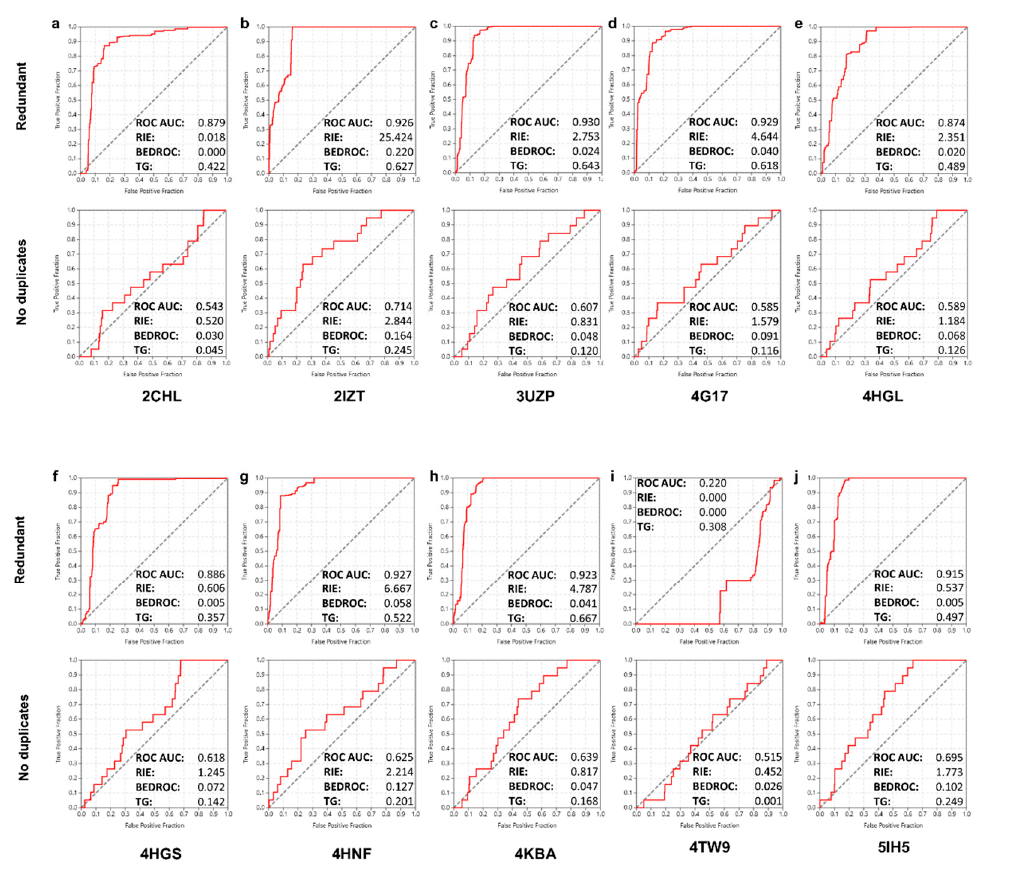
Figure 2. The ROC curves and key enrichment metrics obtained for the subsequent ligand-based screening of the NCI Diversity Set-II against CK1. Results obtained for the 10 different similarity templates (inlets a – j ) along with their corresponding pdb codes are shown. Results from screens following the two distinct approaches with respect to redundancy are distinguished for each